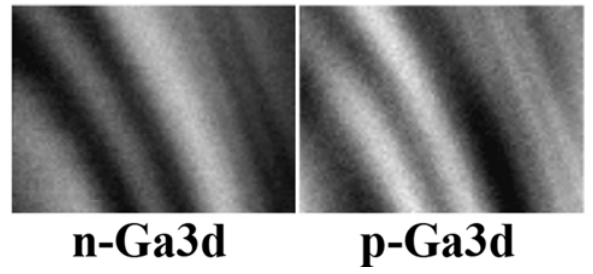
Figure 9. Photoemission intensity images obtained with approach (a) in Figure 7 by selecting photoelectron energies corresponding to the Ga3d core level in n-type and p-type GaAs. The complementary images show the transverse cross section of a complex GaAs structure with n-type and p-type layers. Data from